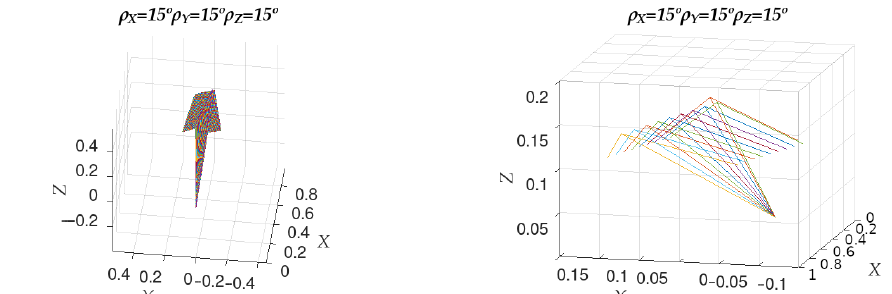
Figure 3. On the left, the orientation of the axes of rotation between the normals of the ideal and calculated planes. On the right, a close-up of the figure on the